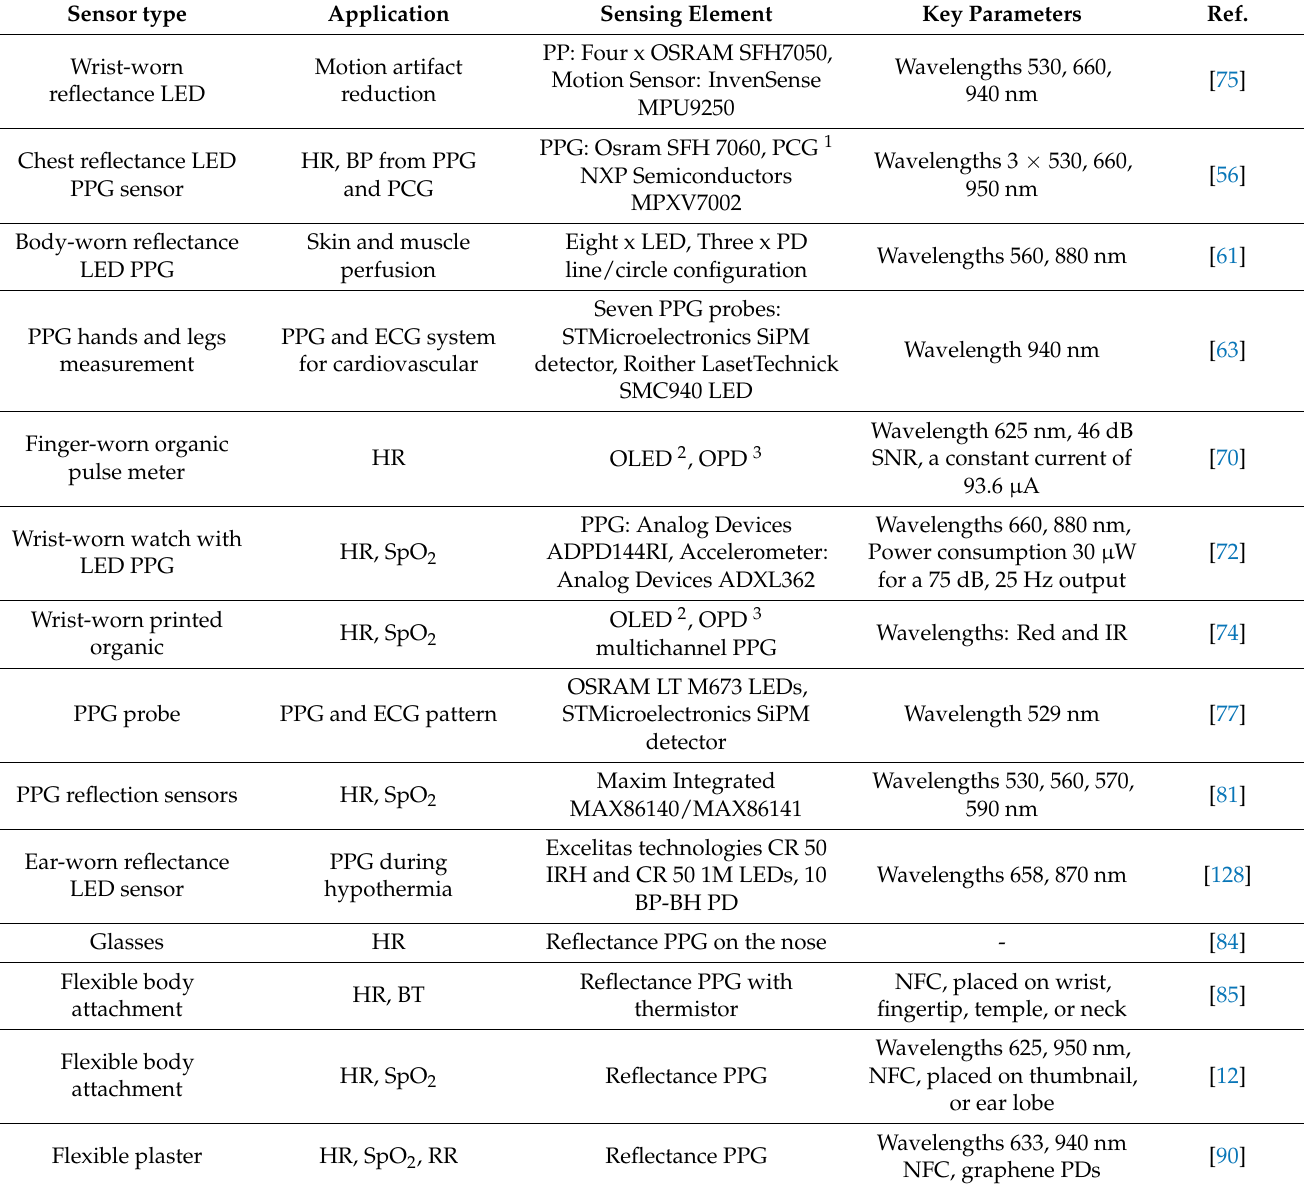
Table 1. Photoplethysmography